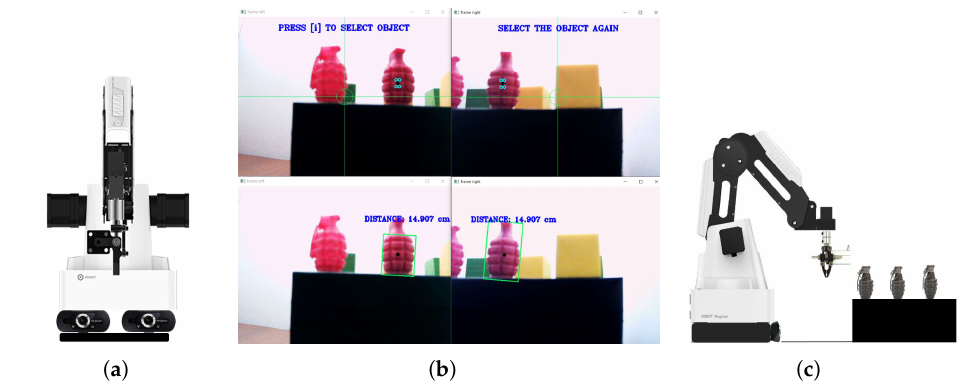
Figure 3. Camera configuration and use of the interface. ( a ) Front view of the robotic arm over stereo cameras. ( b ) Graphic interface for target selection. ( c ) Side view of the final actuator approaching the selected